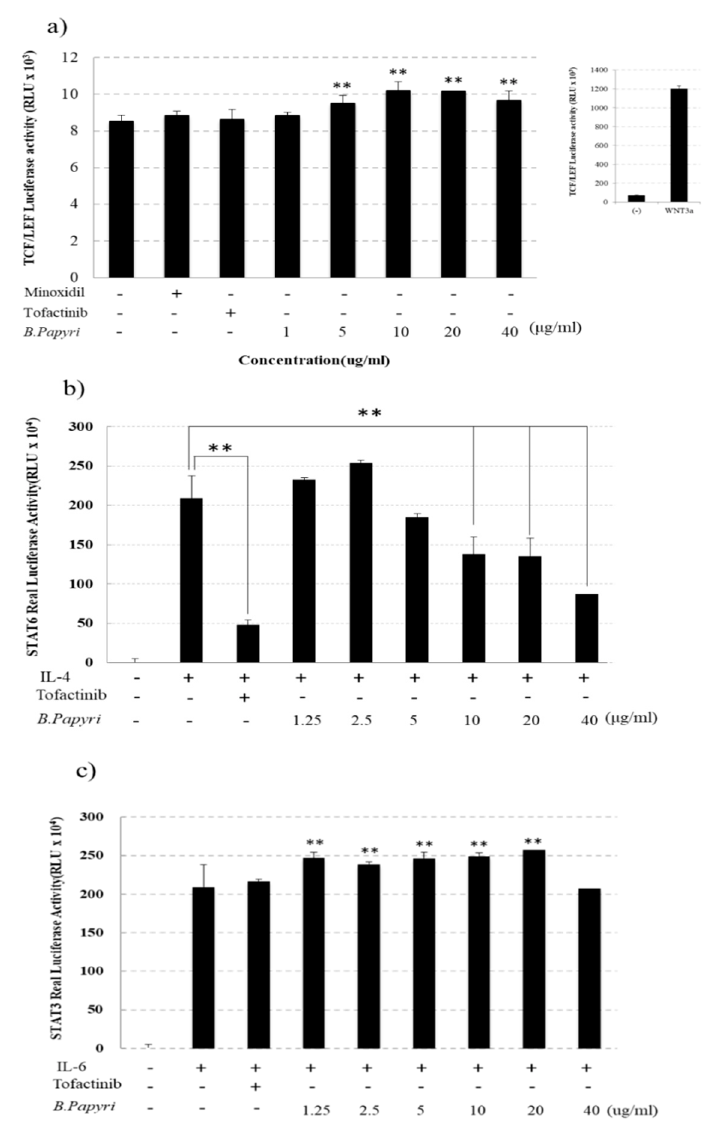
Figure 2. Luciferase activity of reporter gene by B. papyrifera. ( a ) For TCF/LEF reporter gene assay, cells were treated with B. papyrifera (1–40 μ g/ml) for 24. The positive control group was treated with minoxidil (0.4 μ M) or tofactinib (0.4 μ M); ( b ) IL ‐ 4 induced STAT6; and ( c ) IL ‐ 6 induced STAT3 reporter gene assay as determined by luciferase activity. Tofactinib (0.4 μ M), a JAKs inhibitor, was treated as a positive control. Each assay is representative for 3 experiments. The asterisk(s) indicate a significant statistical significance (** p < 0.05).